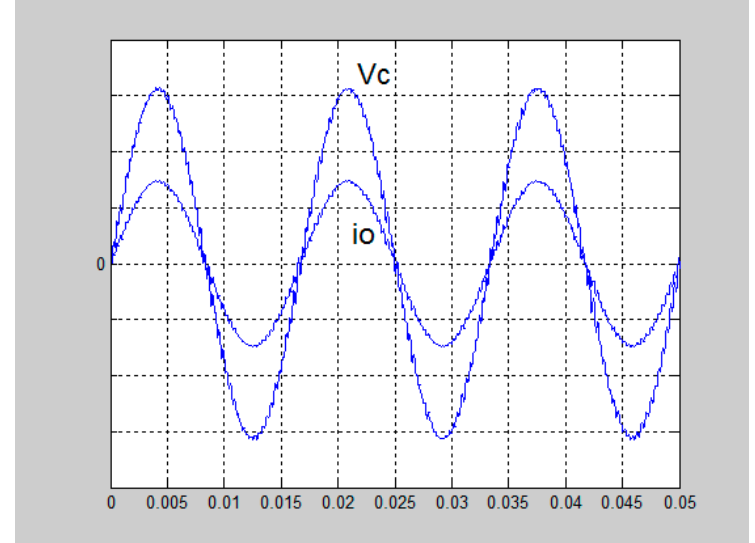
Figure 5. Simulated waveforms under LC variation for the classical terminal sliding mode control (TSMC) (50 V/div; 10 A/div). Table 1. Simulated output-voltage slump and %THD under step loading and LC variation